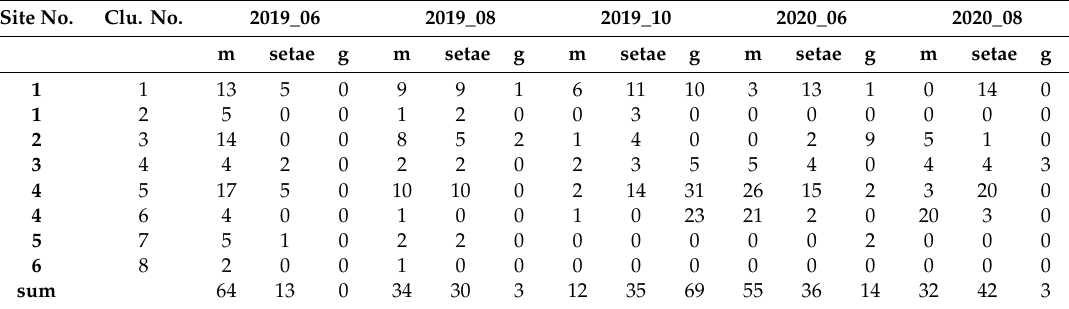
Table 2. The number of sporophytes within each cluster and their variation at five monitoring dates between mid-June 2019 and the end of August 2020; Site No.—site number (see Table 1); Clu. No.— number of the cluster of sporophytes; m—mature sporophyte; setae—sporophyte lacking a capsule; g—green sporophyte.